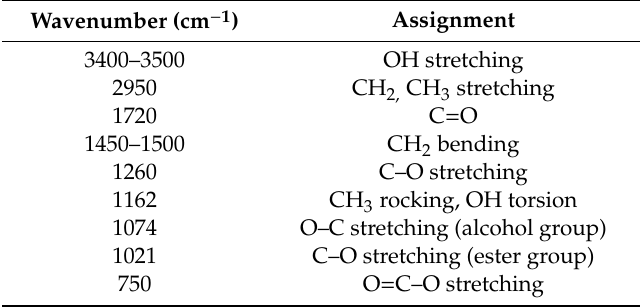
Figure 2. FTIR spectrum of poly(HEMA) nanoparticles crosslinked with EGDMA. The sample used to obtain the image was prepared according to the formulation listed for sample A1 in Table 1. Table 3. Assignments for peaks at specified wavenumbers included in Figure 2.